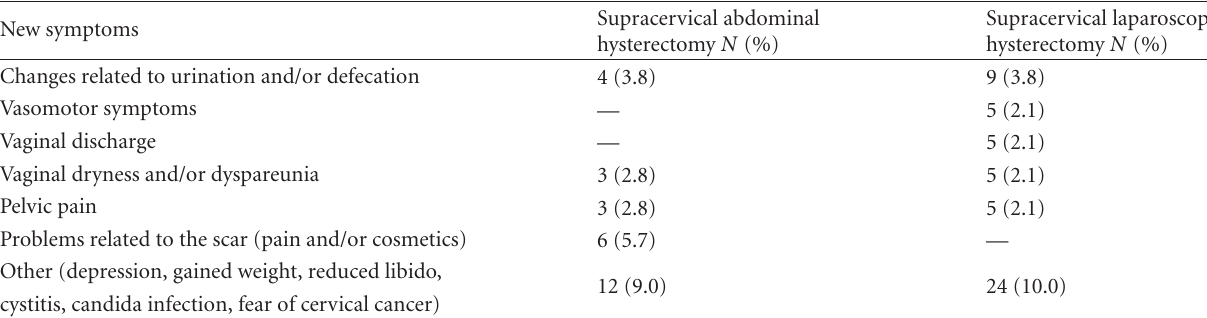
Table 4: New symptoms reported following the